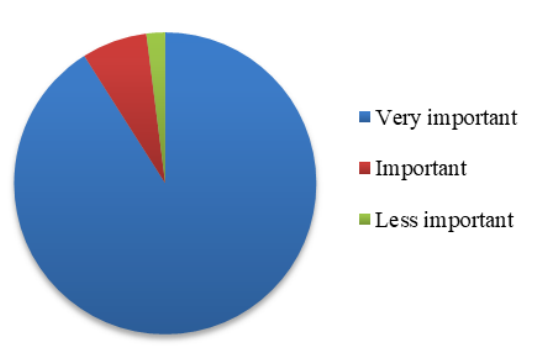
Figure 5. Reasons for the waste going in the wrong bins